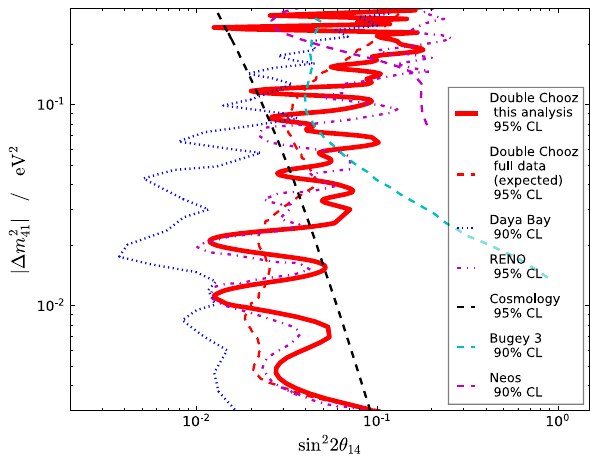
Fig. 12 Comparison of the upper exclusion limits provided by this analysis (Double Chooz) with results from other measurements: Daya Bay [11], RENO [27], Bugey-3 [32] Neos [42], and cosmological limits [10] based on the combination of observations of the cosmic microwave background, gravitational lensing and baryon-acoustic oscillations. Additionally displayed is the expected average sensitivity of Double Chooz with the full data statistics from the multi-detector phase. Note, that the figure combines 1-d and 2-d limits as well as limits of different confidence